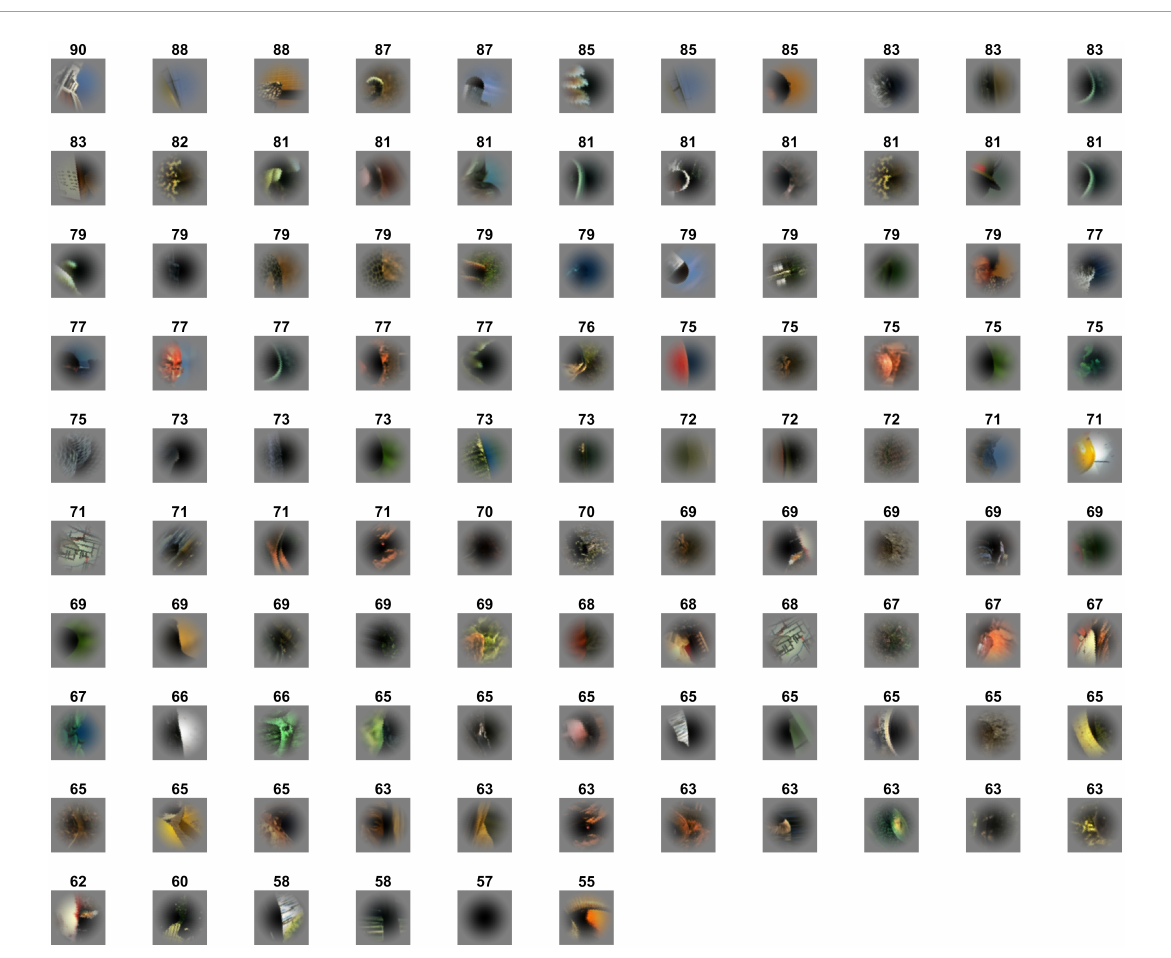
FIGURE1 Local natural scene stimuli cropped from the Berkeley Segmentation Dataset. Stimulus patches were cropped from the Berkeley Segmentation Dataset (BSD) such that the contour of an object passed through the center of the patch. The patches are placed in the rank order of perceptual consistency (the numbers indicate the PC values of the patches); the top-left and bottom-middle with the highest and lowest consistencies, respectively. The patches are rotated so that the figure region is located on the